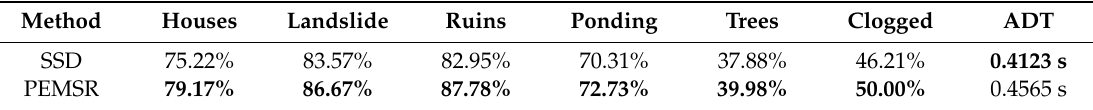
Table 10. F1 score results for PEMSR and the SSD method on the original data. ADT refers to the average detection time and the bold values are the best results among the two methods for each